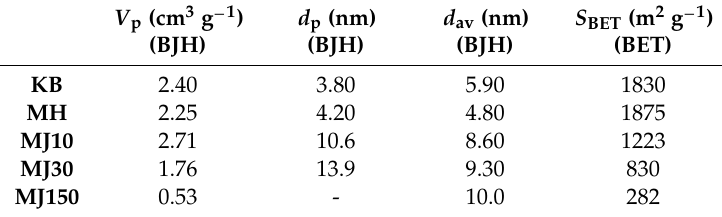
Table 1. Textural properties of KB, MH, MJ10, MJ30, and MJ150.